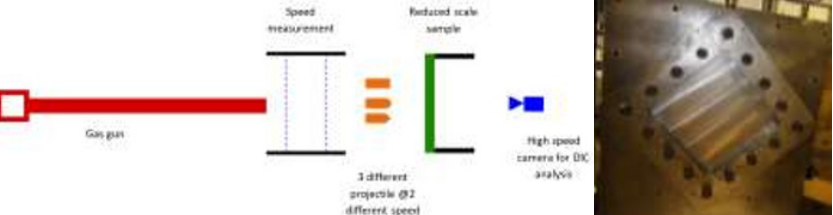
Fig. 8. Test configuration for the punch tests campaign